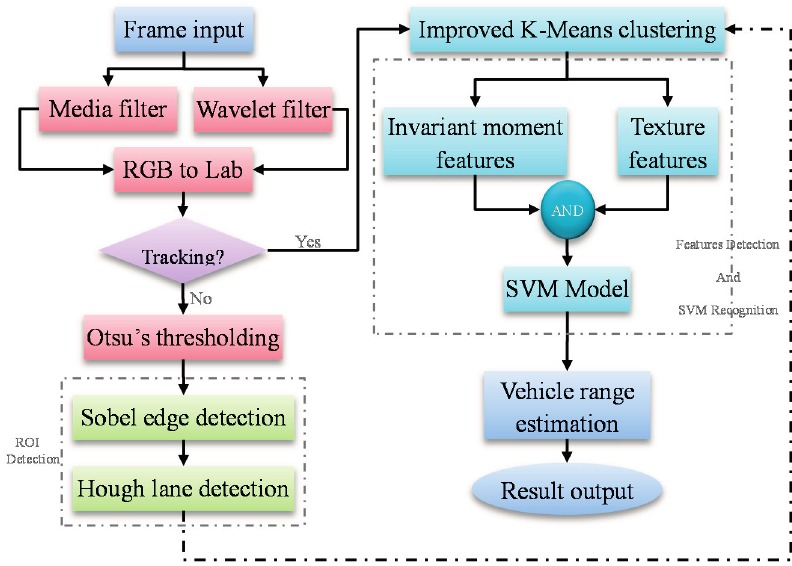
Figure 2. Flow chart of the forward vehicle detection.